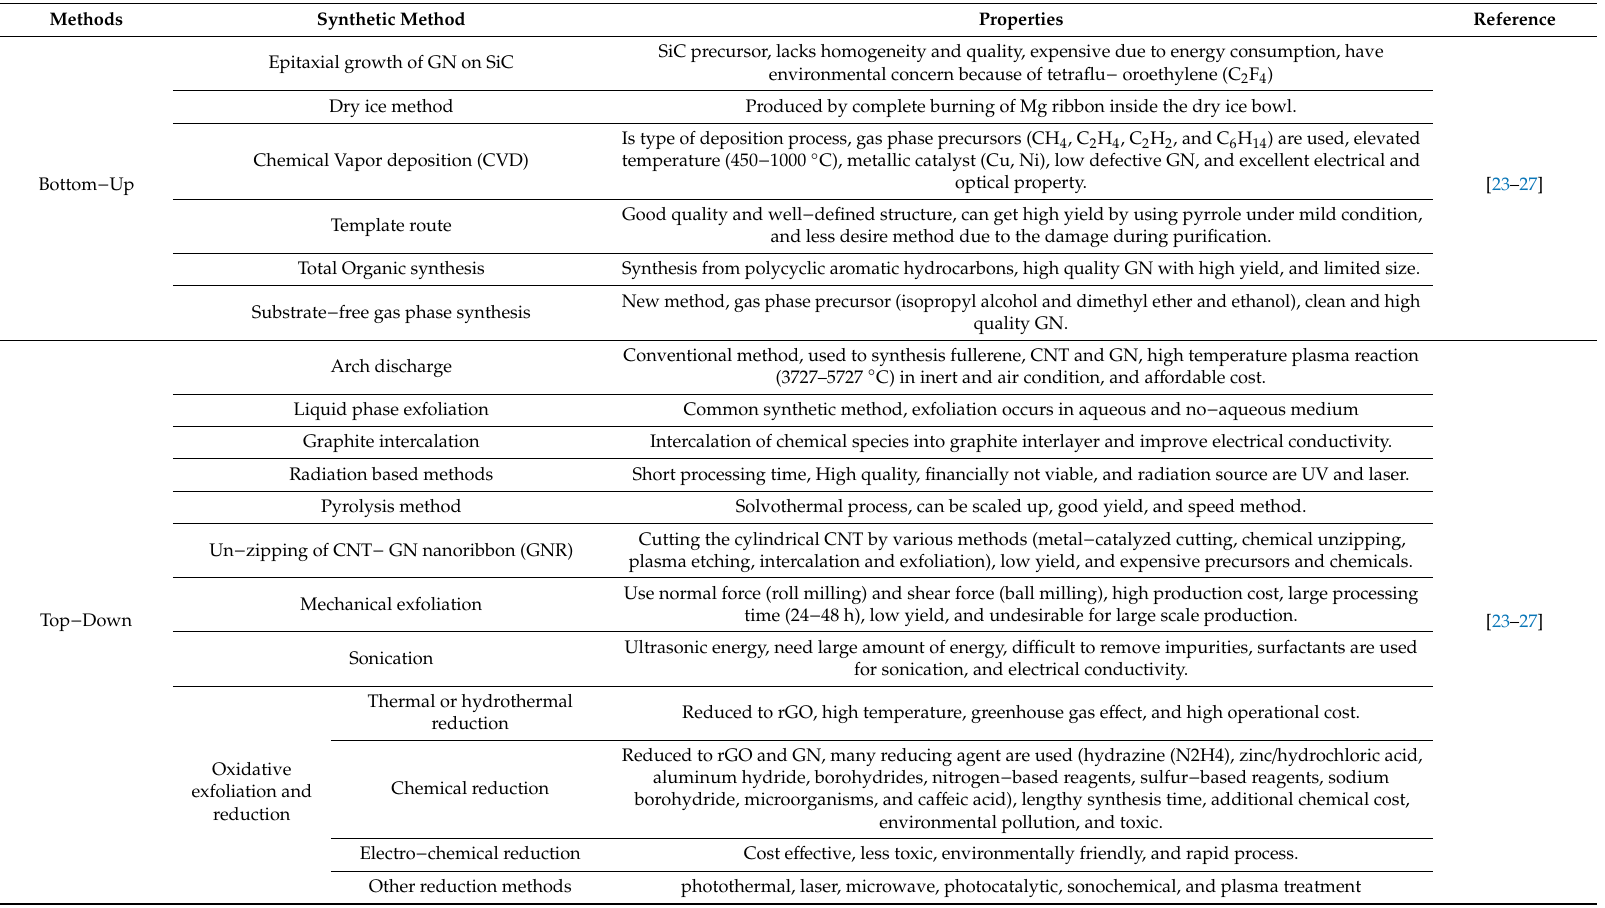
Table 2. Comparison of di ff erent synthetic process of